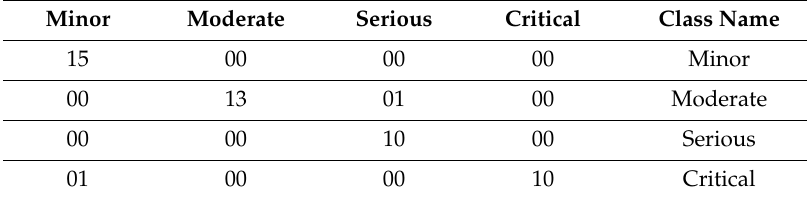
Table 18. Confusion Matrix for fold 2.